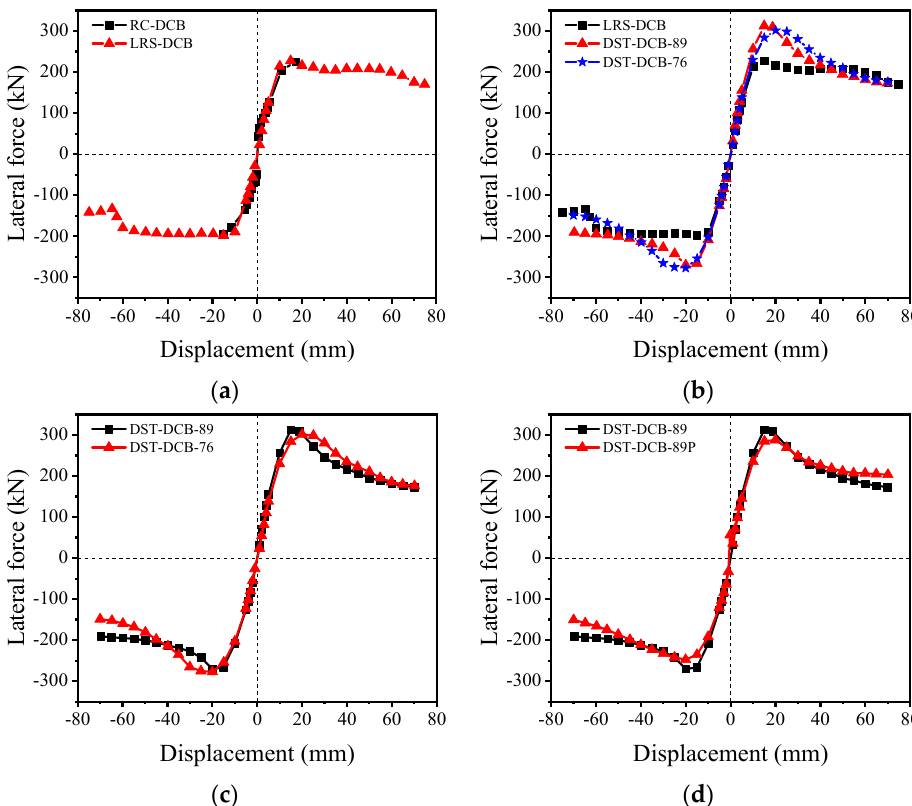
Figure 10. Analysis of the skeleton curves: ( a ) RC-DCB vs LRS-DCB; ( b ) LRS-DCB vs DST-DCB-89 vs DST-DCB-76; ( c ) DST-DCB-89 vs DST-DCB-76; ( d ) DST-DCB-89 vs DST-DCB-89P.